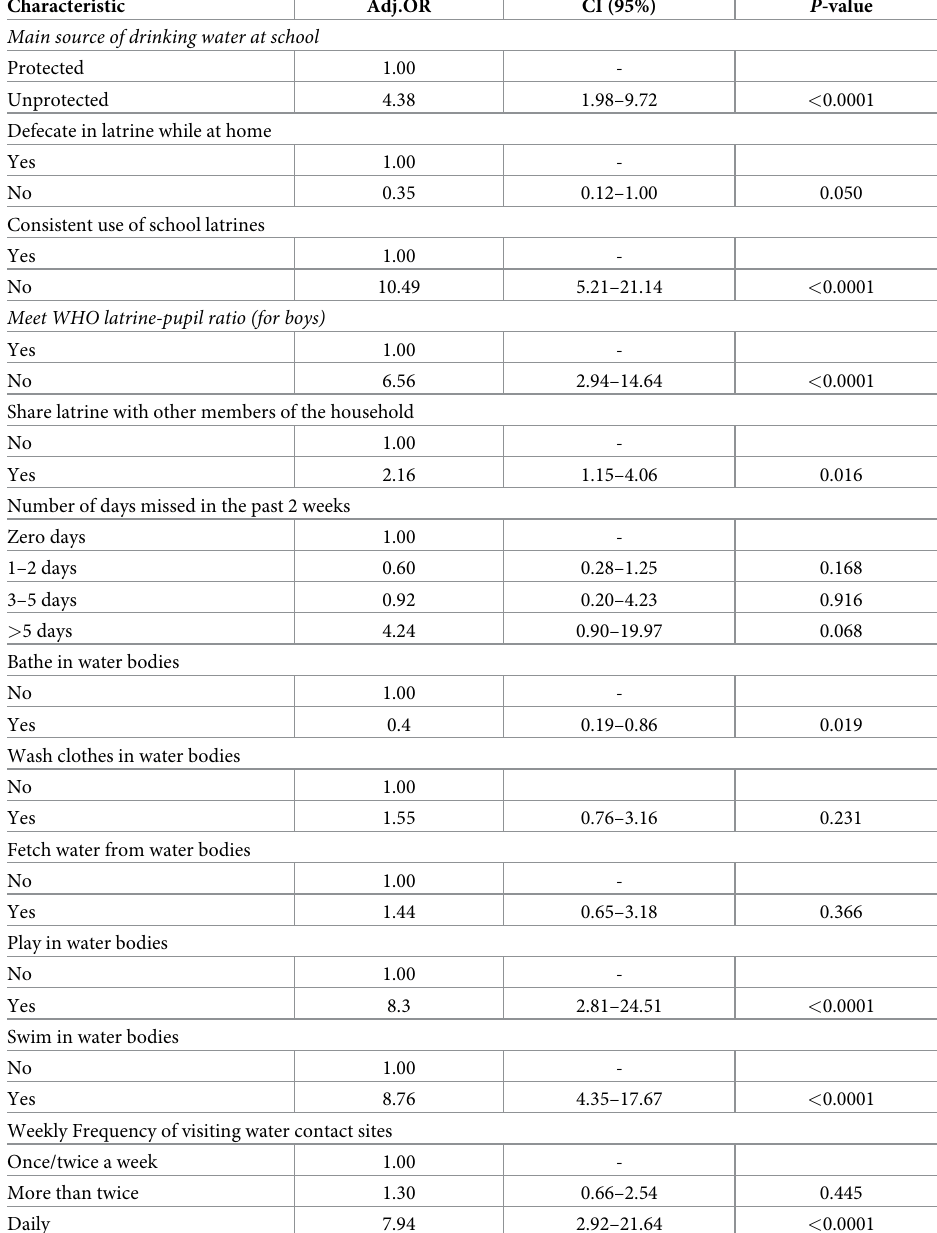
Table 10. Multivariate analysis of the relation between PHS villages and other indicators in the school children population. Characteristic Adj.OR CI (95%) P -value Main source of drinking water at school Protected 1.00 - 4.38 < 0.0001 1.00 -